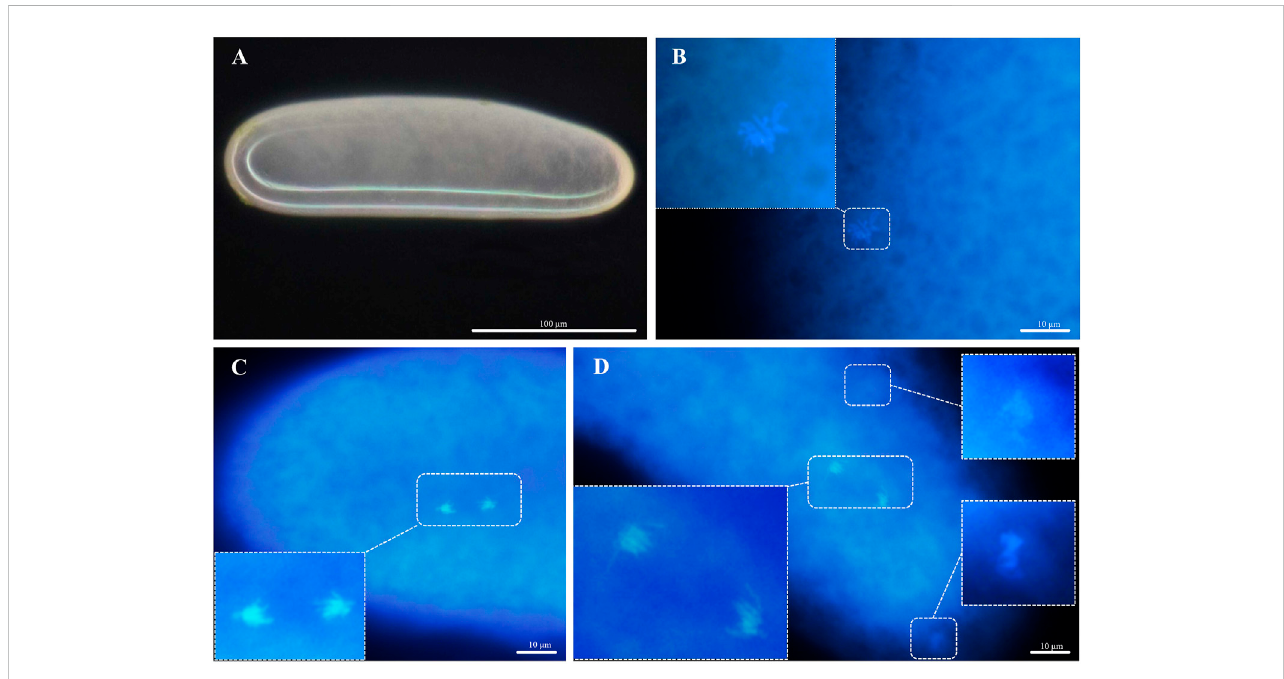
FIGURE 4 Chromosomesinthedepositedeggsofthethelytokousstrain (A) egg,creamywhite,anterioratthetop; (B) fi rstmetaphase (C) fi rstanaphase; (D) second telophase.